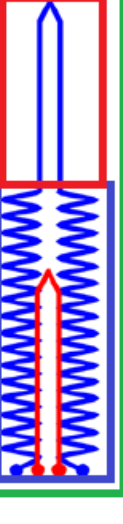
Figure 5. A double layer stretch sensor, where the PIP sensing element (green) is divided into the zigzag and V-shape sections.